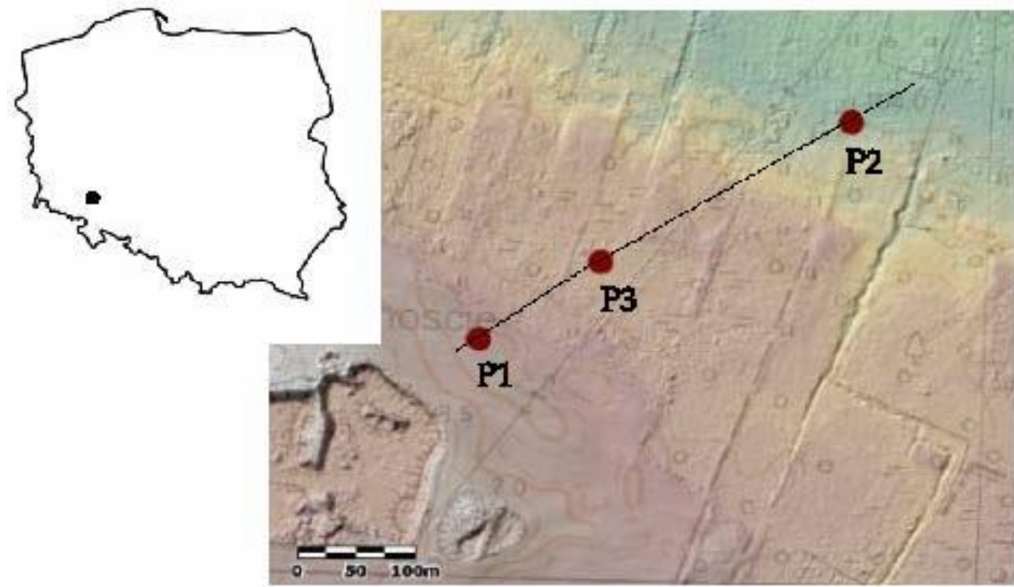
Figure 1. Location of the study area and distribution of soil profiles (P1–P3) in the